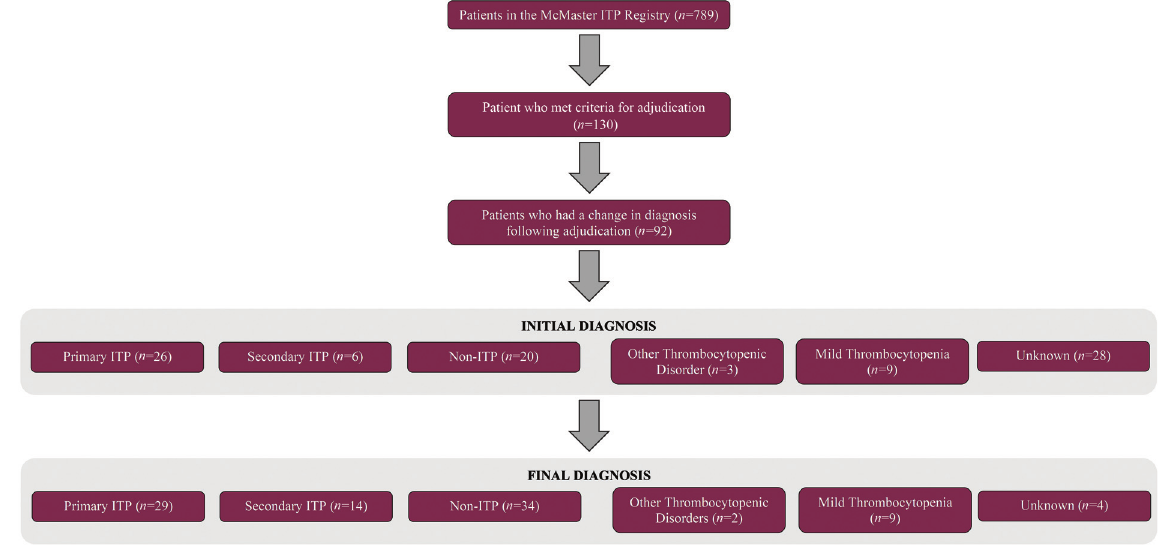
Fig. 2 Flowchart showing the number of patients whose diagnosis changed after adjudication.